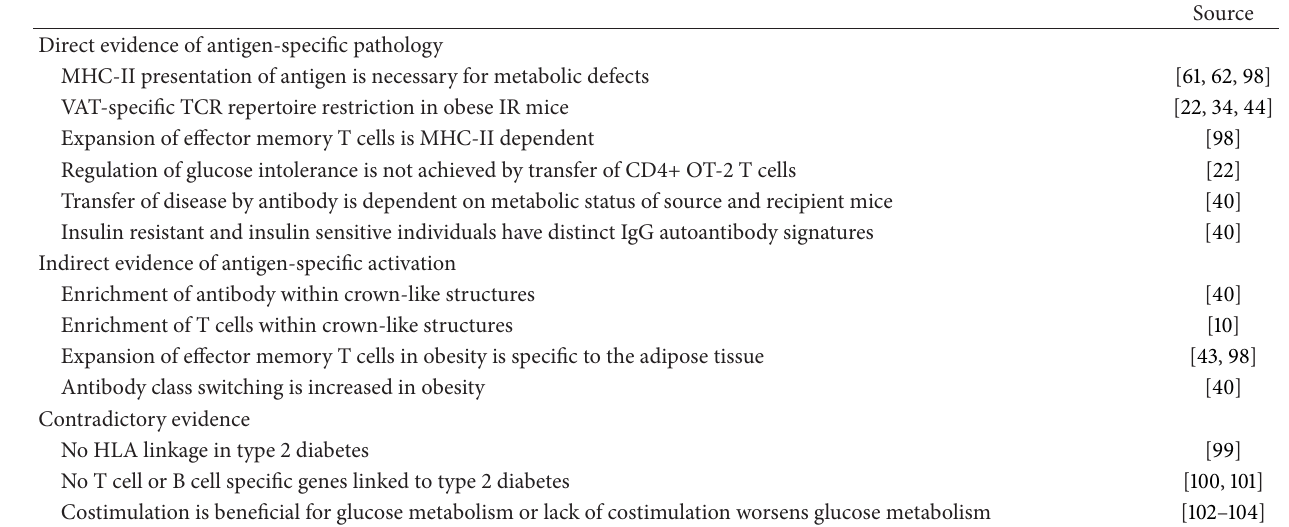
Table 1: Evidence for antigen-specific mechanisms in obesity-associated